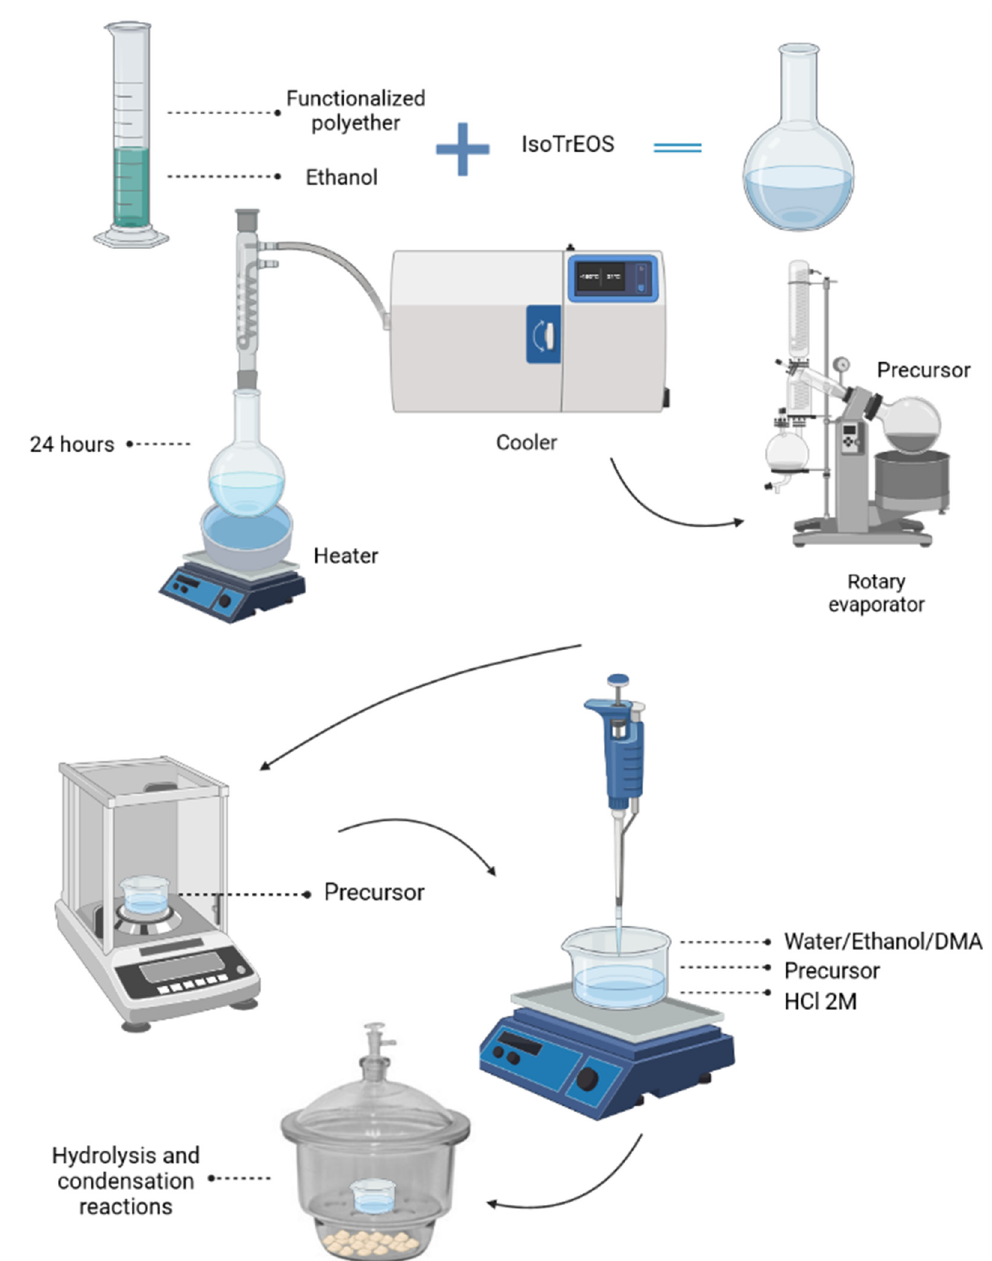
Figure 1. The representative scheme of the methodology steps applied to prepare the hybrids and incorporate dexamethasone. Image created with the assistance of BioRender.